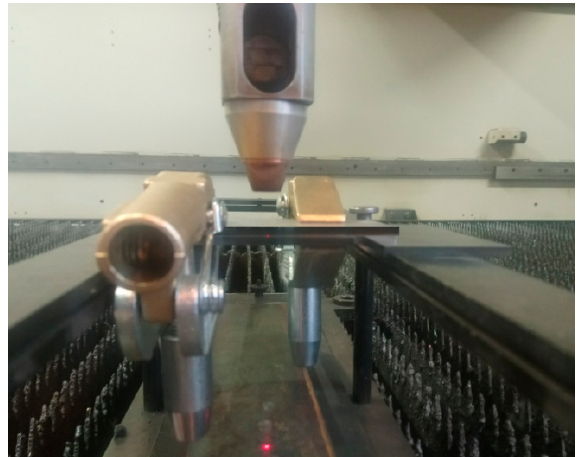
Figure 4. Laser-welding station with lap joint low-carbon steel configuration.